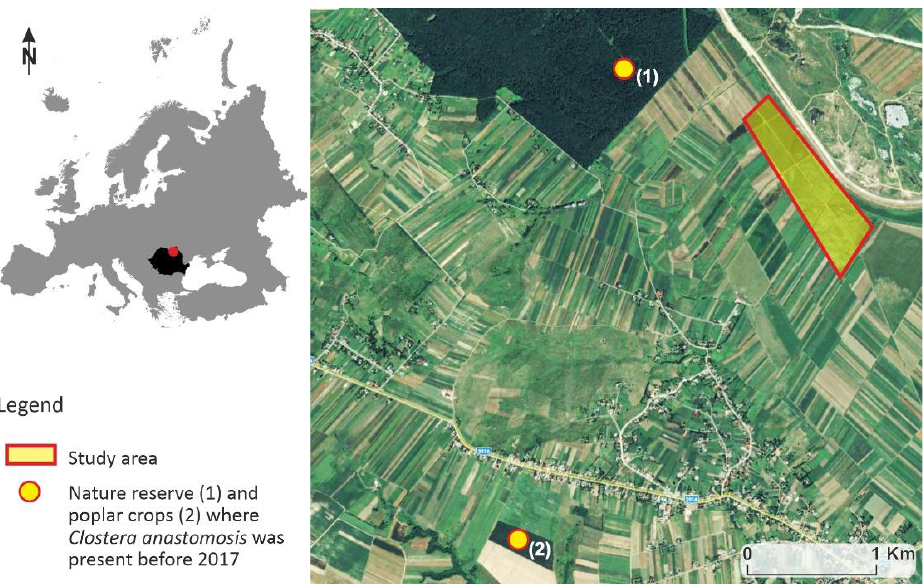
Figure 1. Location of defoliated poplar crop and potential sources (yellow dots, 1 and 2) of Clostera anastomosis (Satellite image source: Google Earth, July 2017 [56]).